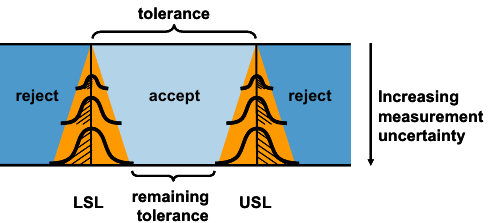
Fig. 6. Conformance according to ISO